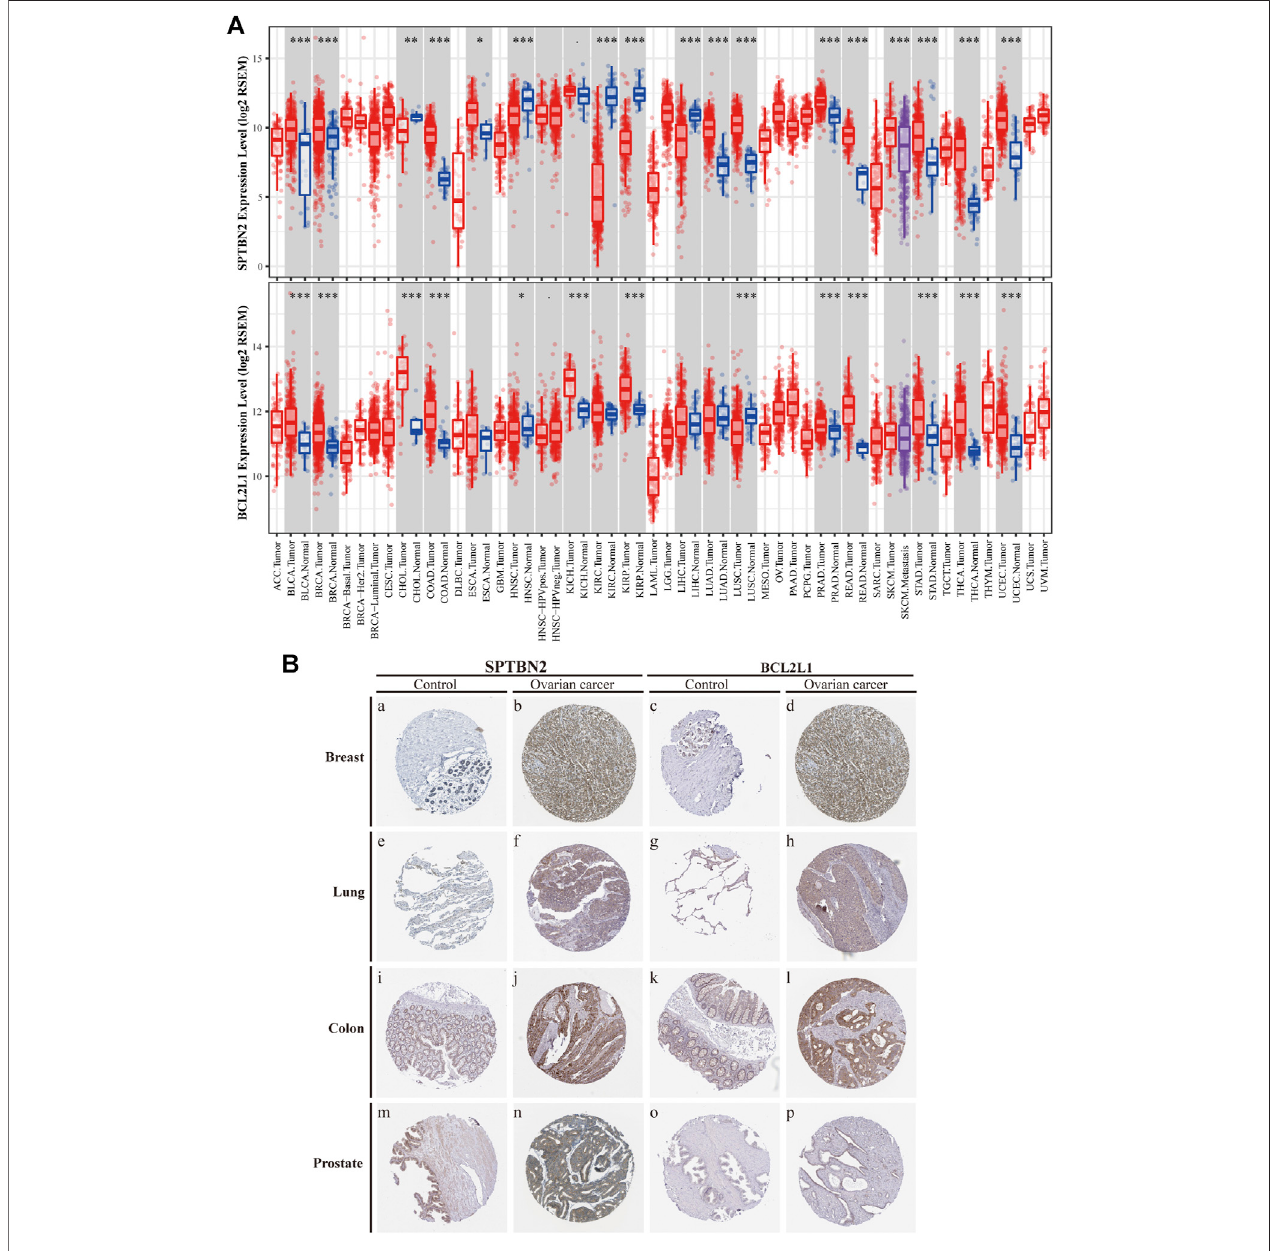
FIGURE 9 | Differential expression of the two hub genes in various types of tumors compared with NC. (A) Distributions of gene expression levels are displayed using box plots from the TIMER database by the Wilcoxon test for SPTBN2 (upper panel) and BCL2L1 (lower panel) . (B) Differential expression at protein levels between cancers and normal tissues, veri fi ed by the protein atlas in the HPA database including the breast, lung, colon, and prostate.